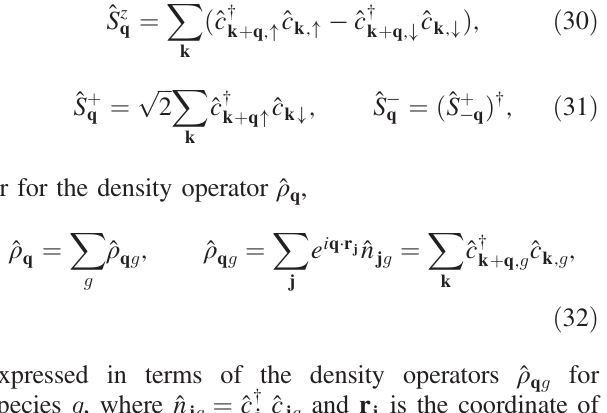
is the critical C; MFT is X